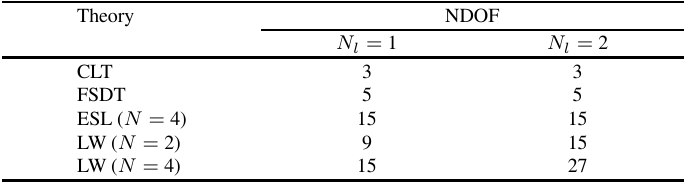
Table 2 Free vibrations of one-layered isotropic shell: fundamental frequency f in Hz for m =